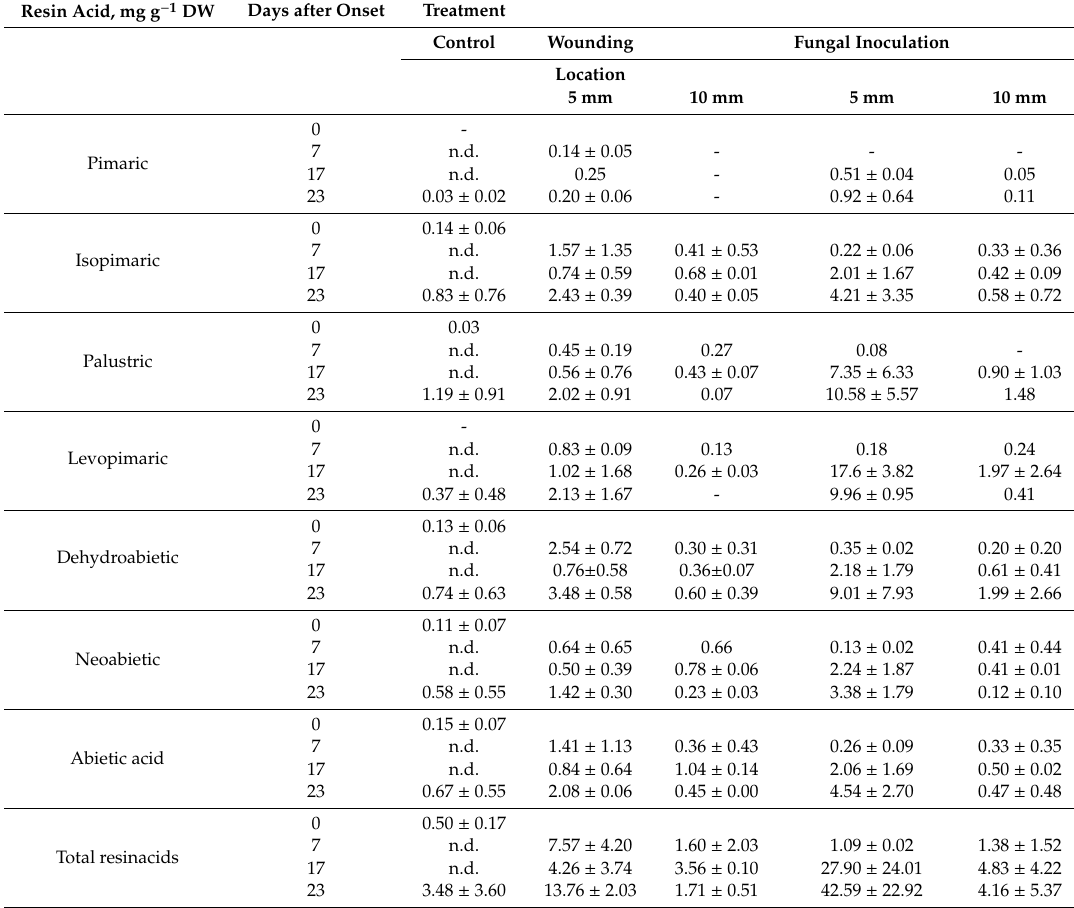
Table 2. Resin acid content (arithmetic mean ± standard deviation) in the bark of young Norway spruce saplings in di ff erent treatments (i.e., unwounded control, wounding, and fungal inoculation) during the period of 23 days after the treatment